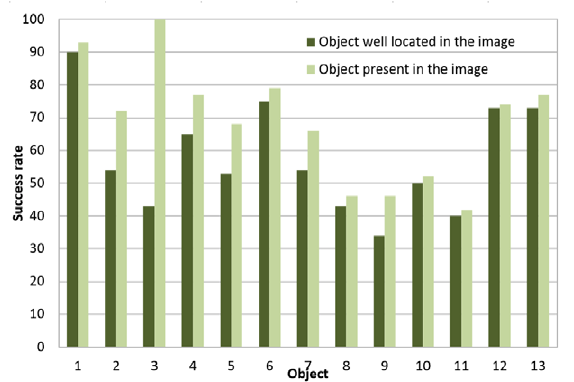
Figure 9: The histogram represents the comparison of two success rates. First, find only the correct object in the image and second, find the correct object and its position in the